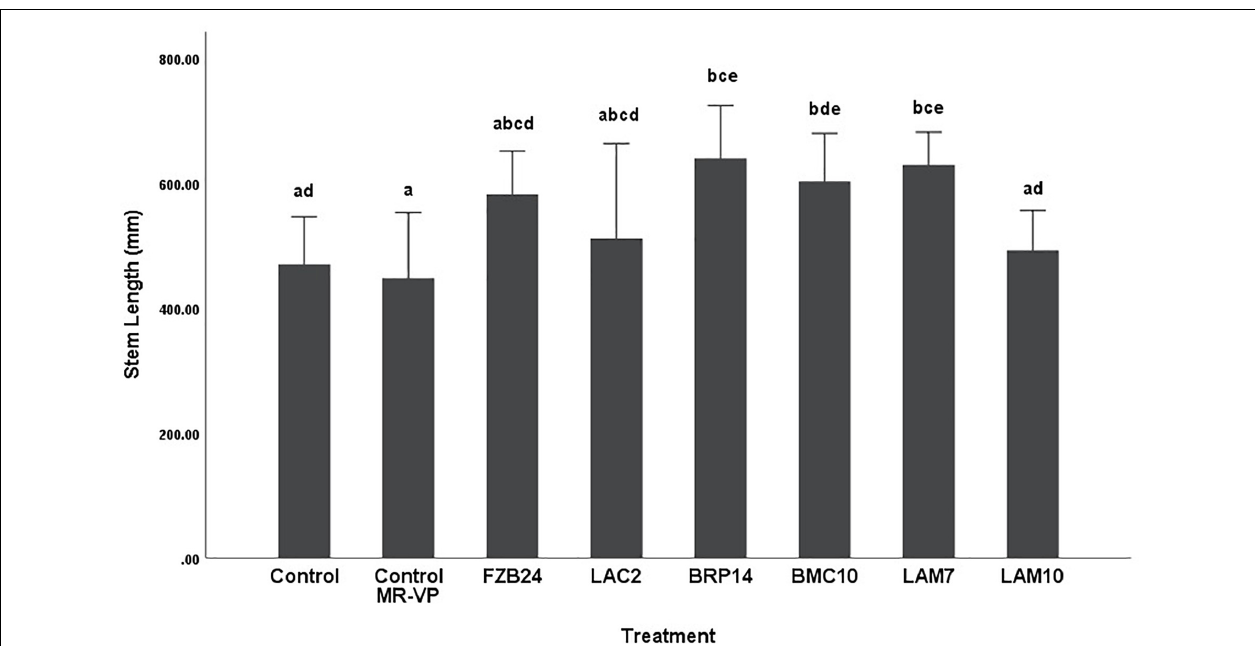
FIGURE 4 | The effect on plant stem length of BVCs from isolates growing on solid MR-VP media. Stem length of plants is measured in (mm), error bars represent confidence interval of the mean (99%) ( n = 8). Isolates which share a common letter are not significantly different to one another ( p > 0.01) according to one-way between groups ANOVA with post hoc Tukey test.